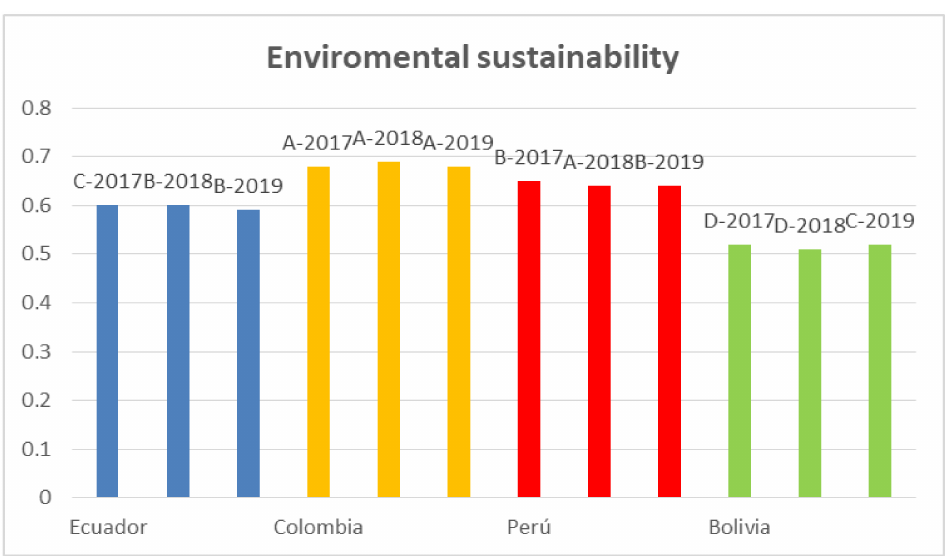
Figure A3. Environmental sustainability dimension by countries in period from 2017 to 2019. A,B,C,D—letter indices according to the WEC methodology: The letter A indicates the highest grade, the letter D—the lowest for each of the dimension.